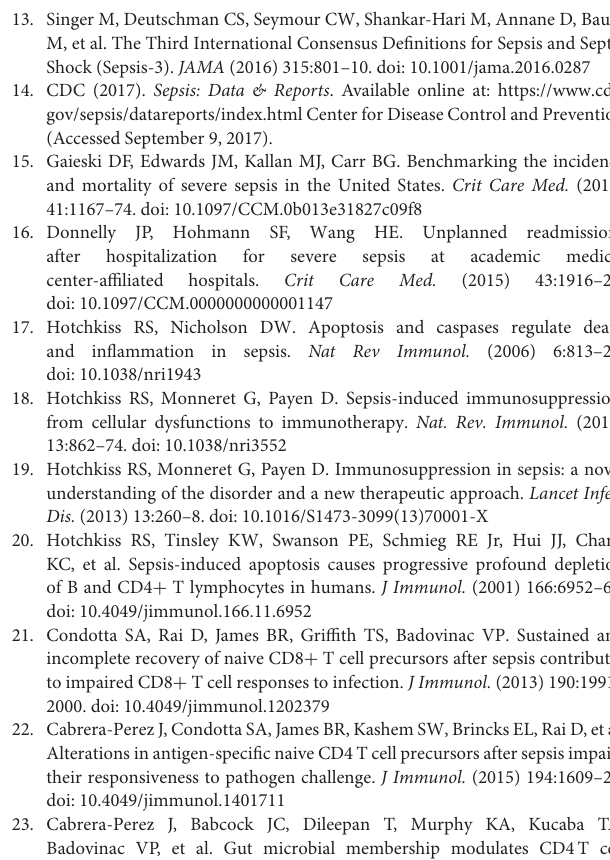
Supplemental Figure 1 | Morbidity, cytokine production, and mortality following CLP surgery. B6 mice underwent sham or CLP surgery. (A) Body weight was measured before and the 7 days after surgery. Weight loss for each was determined based on their starting weight. (B) Serum samples were collected at the indicated time points after sham or CLP surgery. The amount of IL-1 β , IL-6, IFN γ , and TNF in samples was determined by bioplex. n = 11 sham and 38 CLP mice for (A,C) ; n = 5 mice/time point/group in (B) ∗ p < 0.05; ∗∗ p < 0.01, ∗∗∗∗ p < 0.001 for SPF—CLP vs. cohoused—CLP at the indicated time